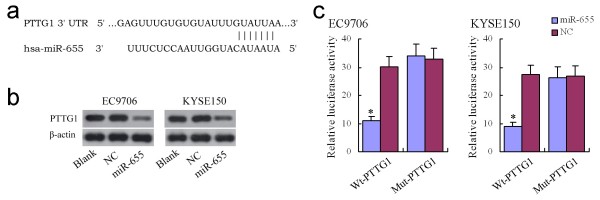
PTTG1 was identified as a target of miR-655 in EC9706 and KYSE150 cells. (a) The putative miR-655 binding sequences for the PTTG1 3’ UTR. (b) Western blot analysis of PTTG1 expression in transfected cells. β-actin was used as a reference. Blank, non-transfected cells; NC, cells transfected with scrambled miR-655 negative control; miR-655, cells transfected with miR-655 mimics. (c) Luciferase activity determined 48 h after transfection. NC, scrambled-miRNA; miR-655, miR-655 mimics; Wt-PTTG1, pGL3-PTTG1-wt; Mut-PTTG1, pGL3-PTTG1-mut. *P < 0.05 compared to the control group.